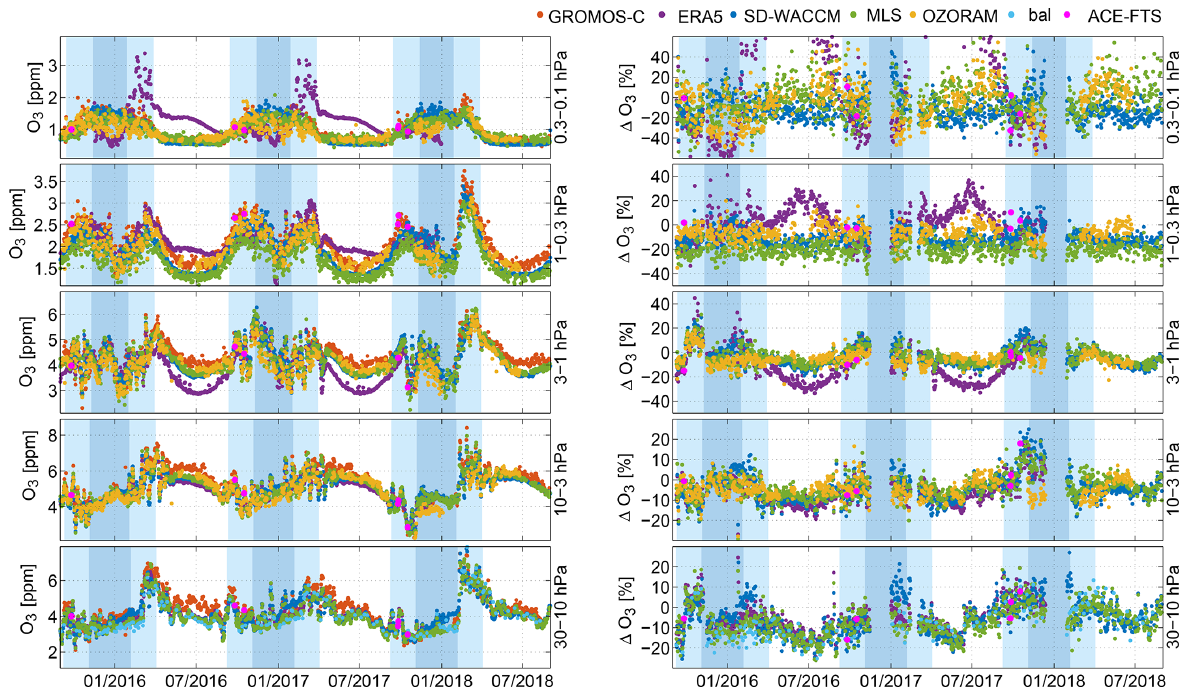
Figure 5. Intercomparison of ozone time series at Ny-Ålesund. On the left are ozone VMR time series of GROMOS-C, OZORAM, ozonesonde, MLS, ACE-FTS, SD-WACCM and ERA5 averaged within five pressure intervals where the lower three intervals are in the stratosphere and the upper two intervals are in the mesosphere. On the right the relative differences to GROMOS-C are shown for the same pressure intervals. The dark blue background indicates polar night and the white background polar day.